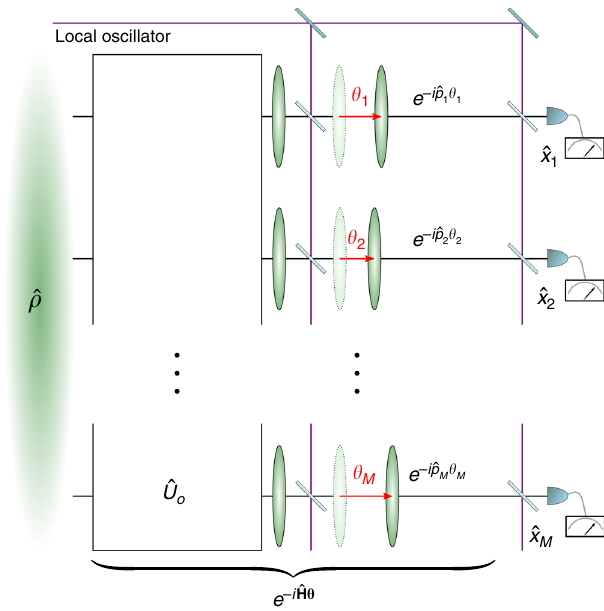
Fig. 3 Optimal multimode displacement sensing with squeezed vacuum states. The passive transformation ^ U O decouples the initial multimode squeezed vacuum state into local squeezed states. A displacement generated by the anti-squeezed variance (here depicted as ^ p ) and a measurement of the squeezed variance ( ^ x ) is implemented in each mode with the aid of a local